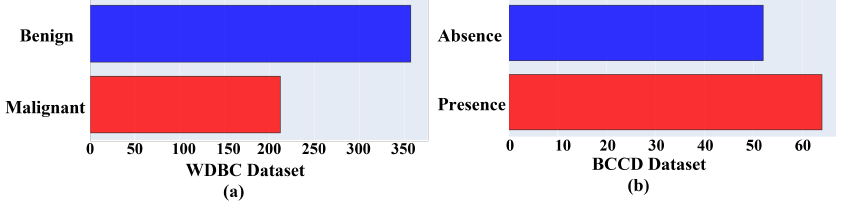
Figure 2. Class distributions of breast cancer datasets with the number of samples; ( a ) indicates WDBC classification into Benign and Malignant; ( b ) presents the BCCD classification into Absence and Presence.